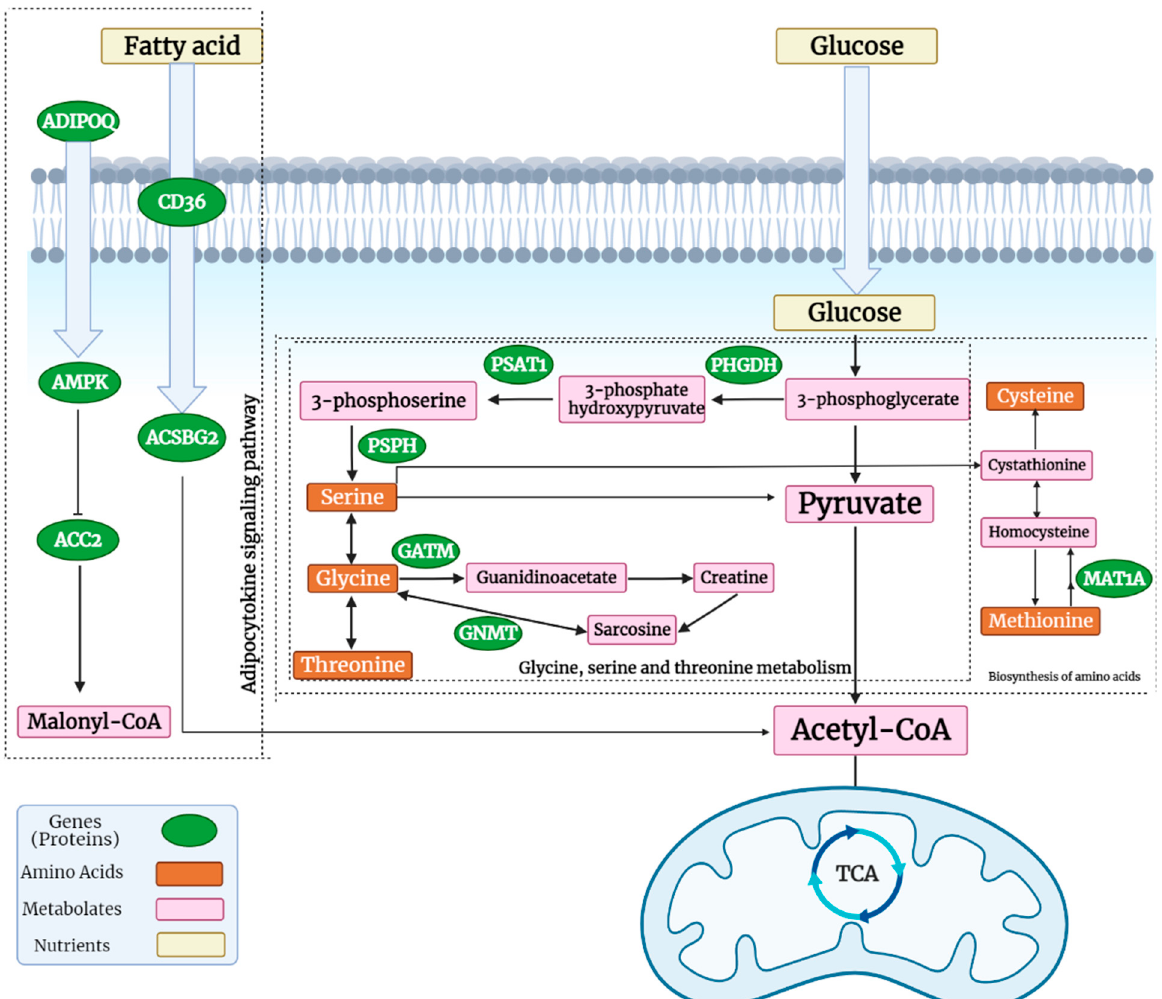
Figure 11. Three important pathways which were significant in HFE turkeys, including glycine, serine, and threonine metabolism, the adipocytokine signaling pathway, and the biosynthesis of amino acids (created with BioRender.com).